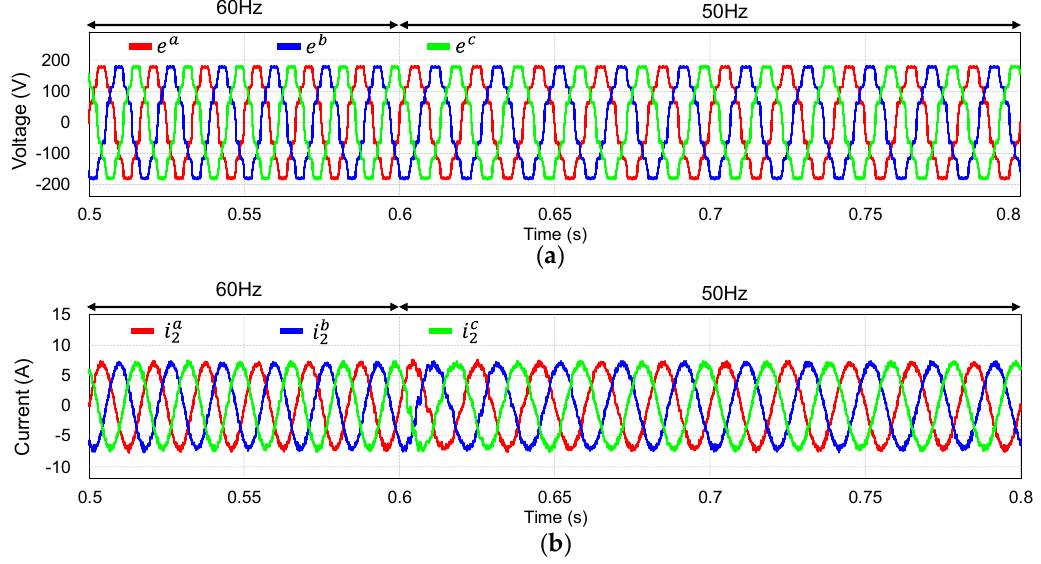
Figure 12. Simulation results for the proposed control scheme under the grid frequency change from 60 Hz to 50 Hz at 0.6 s. ( a ) Three-phase grid voltages; ( b ) Three-phase grid currents.